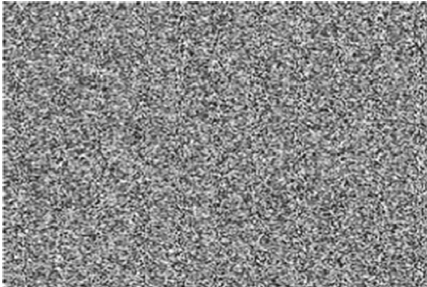
Figure 16: The recovering image under the worry DNA encoding